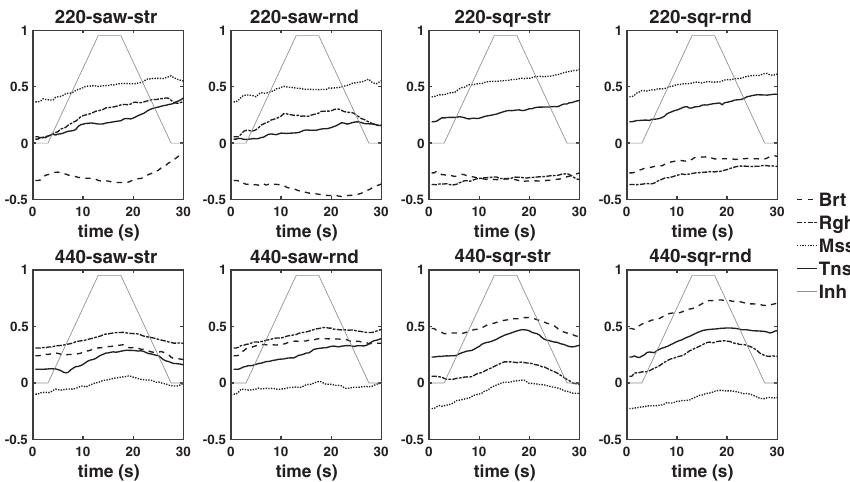
10 20 30 time (s) Figure 4. Mean values of the brightness, roughness, mass and tension pro fi les for each of the stimuli. 220-saw-str: , 220-saw-rnd: , 220-sqr-str: , 220-sqr-rnd: , 440-saw-str: , 440-saw-rnd: , 440-sqr-str: , 440-sqr-rnd: (please use headphones for listening to the accompanying audio fi les). The grey line shows the function of inharmonicity variation over time: zero 0 – 3 s, linear increase 3 – 13 s, one 13 – 17 s, linear decrease 17 – 27 s, zero 27 – 30 s. The initial offset for each quality and each stimulus is the corresponding median value from the static ratings (see Fig. 2).